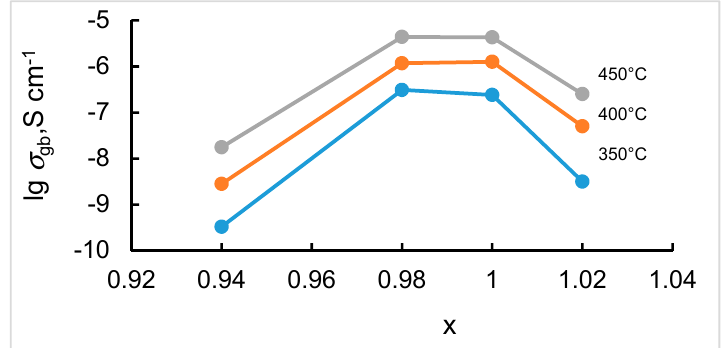
Figure 8. Grain boundary conductivity of SZYx as a function of strontium content in air (pH 2 O = 40 Pa). The lines between points are only a guide to the eye.